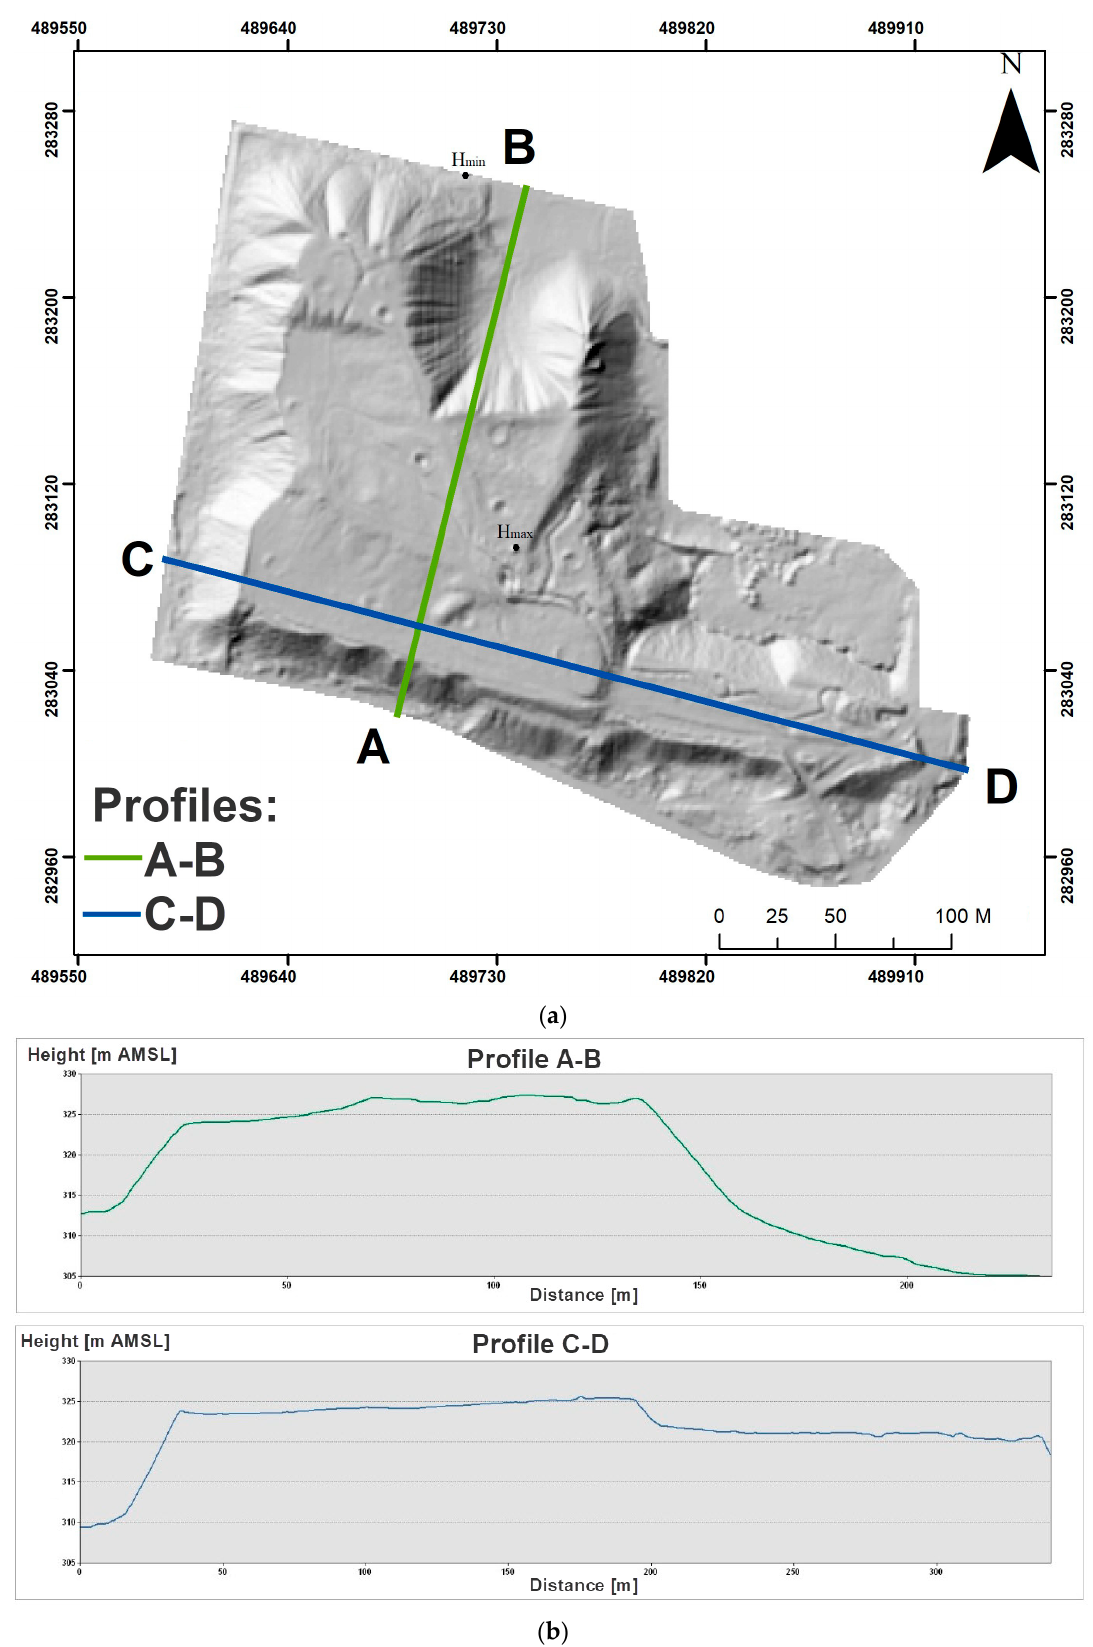
Figure 4. The analyzed terrain: ( a ) hillshade with marked profiles, ( b ) profiles.